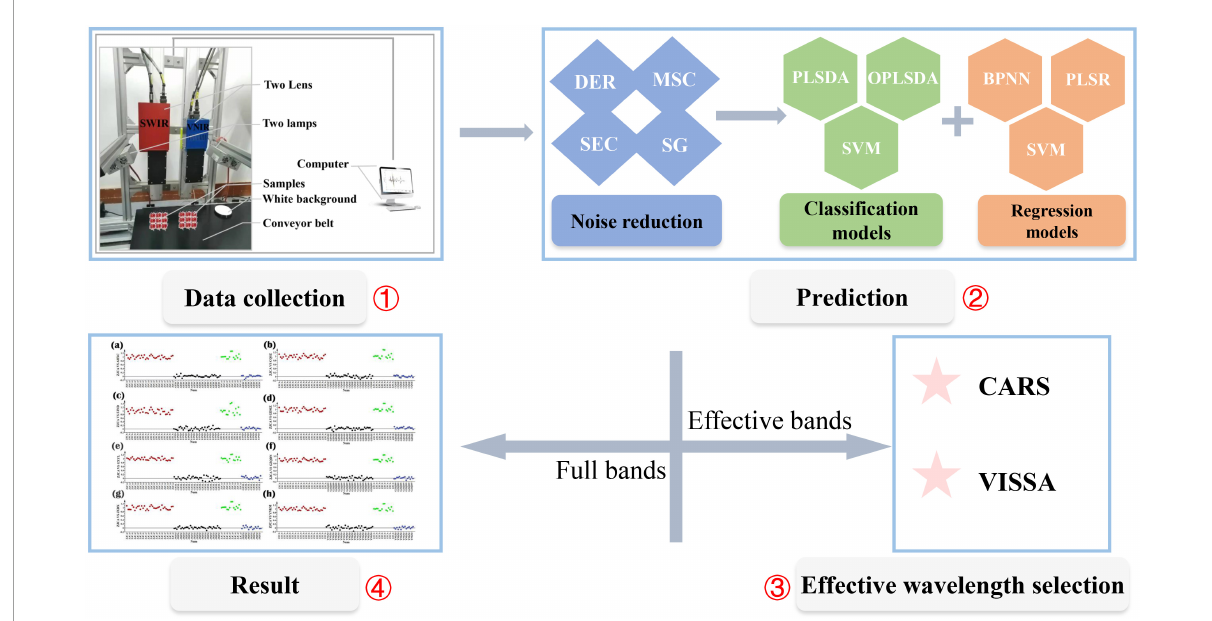
FIGURE1 The specific process of the analysis. The workflow includes four parts, i.e., data collection, indicators prediction, effective wavelengths selection, and results analysis. Four pretreatment methods were considered, including the first derivative (DER), multiplicative signal correction (MSC), the second derivative (SEC), and Savitzky-Golay filtering (SG). Three regression models, including back-propagation neural network (BPNN), partial least square regression (PLSR), and support vector machines (SVM), were used for contents prediction. Three classification models, including orthogonal partial least squares discrimination analysis (OPLSDA), partial least squares discriminant analysis (PLSDA), and support vector machines (SVM), were used for origins prediction. Two wavelength selection methods were considered, including competitive adaptive reweighted sampling (CARS) and variable iterative space shrinkage approach